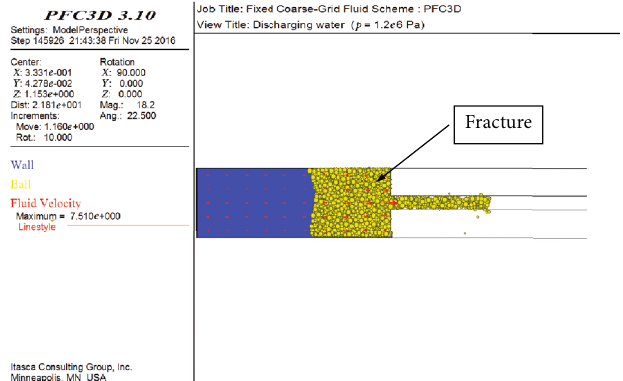
Figure 10: The overall increase in the process of particle fl